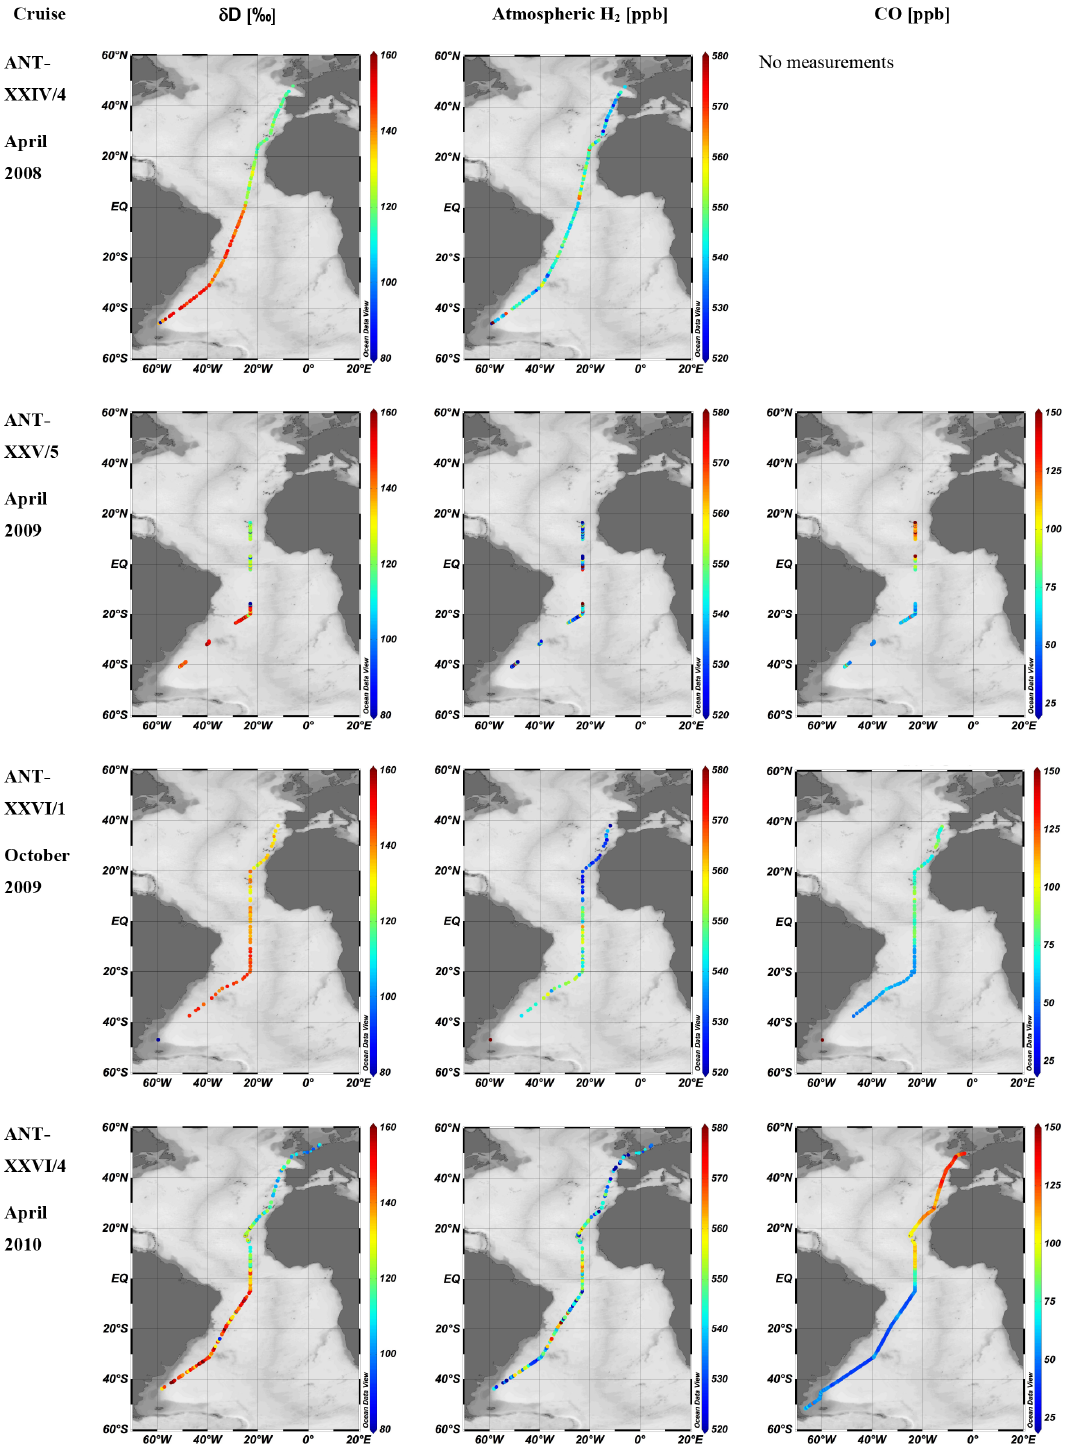
Figure 4. δ D (H 2 ) (‰) (first column), H 2 mole fraction (ppb) (second column), and CO mole fraction (ppb) (third column), along the meridional cruise tracks of RV Polarstern , the mole fraction and δ D of H 2 are measured by IRMS, the CO mole fraction by